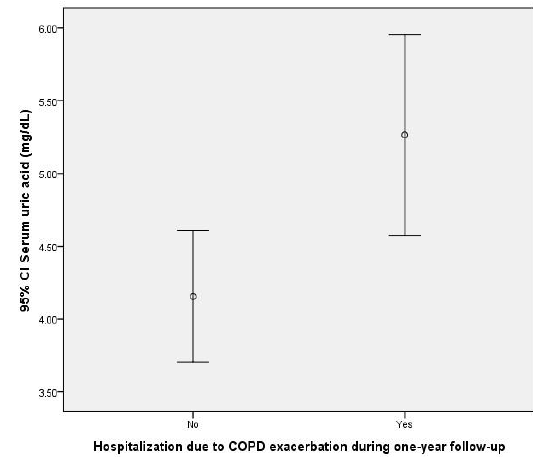
Figure 2. Error bar showing comparison of mean serum uric acid level and its 95% CI (confidence interval) between patients who were admitted to hospital because of COPD exacerbation vs. those not